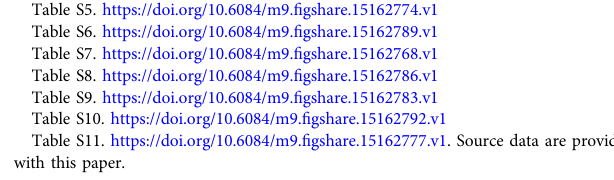
Table S5. https://doi.org/10.6084/m9. fi gshare.15162774.v1 Table S6. https://doi.org/10.6084/m9. fi gshare.15162789.v1 Table S7. https://doi.org/10.6084/m9. fi gshare.15162768.v1 Table S8. https://doi.org/10.6084/m9. fi gshare.15162786.v1 Table S9. https://doi.org/10.6084/m9. fi gshare.15162783.v1 Table S10. https://doi.org/10.6084/m9. fi gshare.15162792.v1 Table S11. https://doi.org/10.6084/m9. fi gshare.15162777.v1. Source data are provided with this